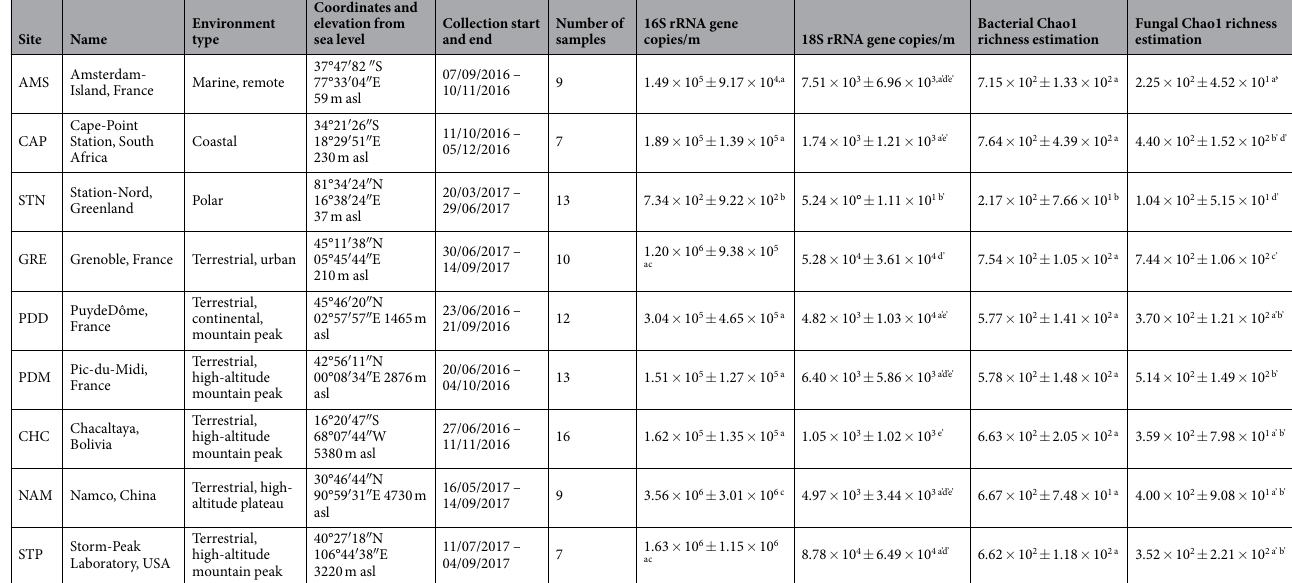
Real-time qPCR analyses on the 16S rRNA (data previously published in Dommergue et al., (2019) 27 ) and 18S rRNA genes were carried out (regions, primers 30,31 and protocols in Supplementary Information) to approxi- mate the concentration of bacterial and fungal cells per cubic meter of air. Although bacteria and fungi might have more than one copy of 16S rRNA and 18S rRNA gene per genome, respectively, attempts to correct for metagenomics datasets are unproductive 32 . Microbial community structure was obtained using MiSeq Illumina amplicon sequencing of the bacterial V3-V4 region of the 16S rRNA gene and the fungal ITS2 region. The library preparation protocol, read quality filtering and taxonomic annotation of every sequence using RDP Classifier 33 are detailed in Supplementary Information. RDP classifier was used in part to avoid errors due to sequence clus- tering. The raw read number per sample and the percentage of sequences annotated using RDP Classifier for both the 16S rRNA gene and ITS sequencings are presented in Supplementary Table S1. All graphical and multivariate statistical analyses were carried out in the R environment, using the vegan 34 , pvclust 35 , ade4 36 and Hmisc 37 R packages. The raw abundances of the bacterial genera or fungal species were transformed in relative abundances to counter the heterogeneity in the number of sequences per sample and then standardized using Hellinger’s transformation. Chao1 estimations of the richness for both bacterial and fungal communities were calculated and averaged for each site. MODIS (Moderate resolution imaging spectroradiom- eter) land cover approach (5 ′ × 5 ′ resolution) 38,39 was used to quantify landscapes in a diameter range of the sam- pling sites (50, 100 and 300 km). The perimeter of 50 km was chosen because the landscapes were best correlated to airborne microbial community structures. The different MODIS land covers are described in Supplementary Table S2. We weighted these relative surfaces by their associated bacterial cell concentration reported by Burrows et al., (2009) 40,41 (Supplementary Table S3) to predict the relative contribution of each landscape to the aerial emission of bacterial cells. Hierarchical clustering analyses (average method) were carried out on either the Bray-Curtis dissimilarity matrix (bacterial and fungal community structure) or the Euclidean distance matrix (PM10 chemistry, land- scapes and the relative contributions of the landscapes). A Mantel test was used to evaluate the similarities in the distribution of the samples in the different data sets. Distance-based redundancy analyses (RDA) were car- ried out to evaluate the part of the variance between the samples based on the microbial community structure explained by chemistry. Prior to the cluster analysis based of the chemical dataset, chemical concentrations were log10-transformed to approach a Gaussian distribution. SIMPER analysis was used to identify the major bacterial or fungal contributors to the difference between the detected groups. Spearman correlations were calculated to test the correlation between microbial abundance and richness and quantitative environmental factors like chemical concentrations or meteorological parameters. ANOVAs were used to test the influence of qualitative factors such as localization on both bacterial and fungal abundance and richness and TukeyHSD tests to identify which group had a significantly different mean. To compare the temporal variability in microbial communities at each site, we interpreted both the Bray-Curtis dissimilarity value averaged per site and the associated standard deviation. We calculated a new statistic, i.e . a similarity index, as follows. We averaged the values of dissimilarity obtained from the Bray-Curtis matrix for each pair of samples from the same